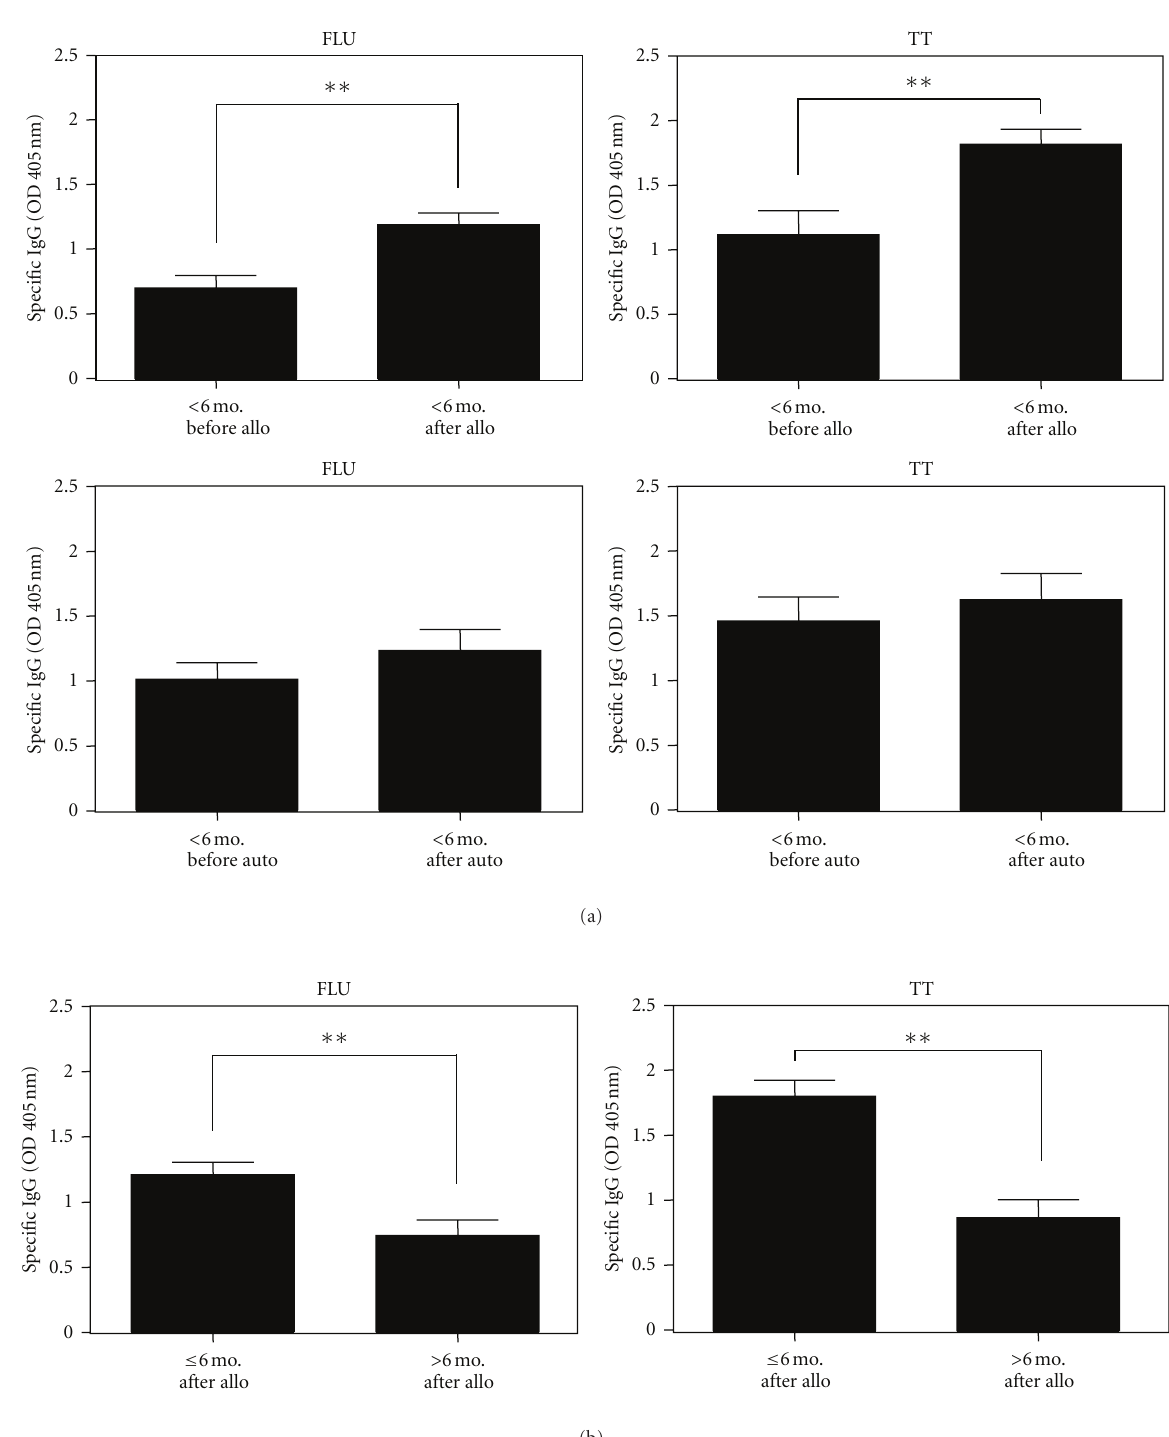
Figure 3: Time-dependent impact of alloSCT on FLU- and TT-specific antibodies in selected patients. (a) Comparison of FLU and TT antibodies 6 months before and 6 months after alloSCT and autoSCT. For 21 alloSCT patients and for 14 autoSCT patients, samples had been collected for both of these time points. Di ff erences were significant with P < 0 . 001 for FLU-antibodies before and after alloSCT and with P < 0 . 0001 for TT antibodies before and after alloSCT. No significant di ff erences were found between FLU and TT antibody concentrations before and after autoSCT. (b) Comparison of FLU and TT antibodies collected less than 6 months after alloSCT and more than 6 months after alloSCT. Samples had been collected from 20 alloSCT patients at both time points. Di ff erences in antibody titers were significant in the case of anti-FLU ( P < 0 . 01) and anti-TT antibodies ( P < 0 .